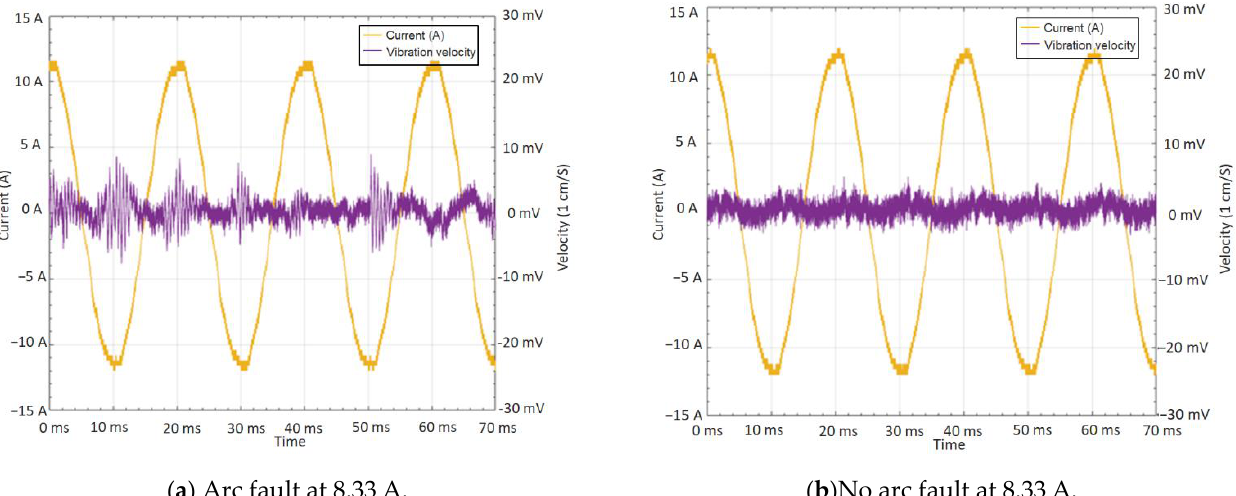
Figure 6. The voltage waveform and the vibration velocity waveform. ( a ) When there is poor contact in an arc-fault state, it is observed that the point of contact generates vibration pulses at twice the frequency of the AC power supply. ( b ) When contact between the two electrodes is poor with no electrical discharge between the contact points, the vibration is still present, albeit at a significantly lower strength than that in the electrical discharge state.